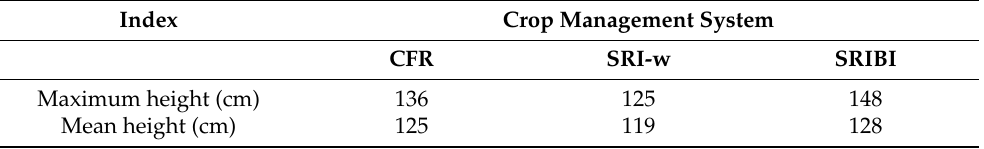
Table 3. A comparison of plant height parameters observed for the three different treatments (2019).